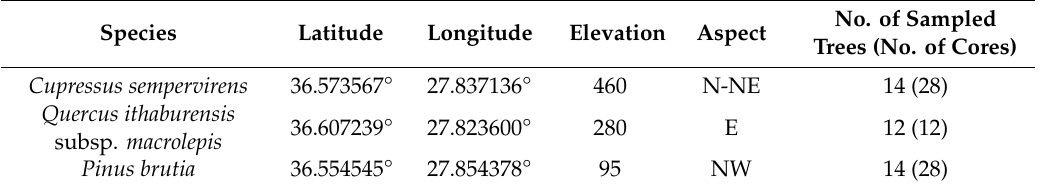
Table 1. General characteristics of the three study sites from where cores from living trees were collected. Species Latitude